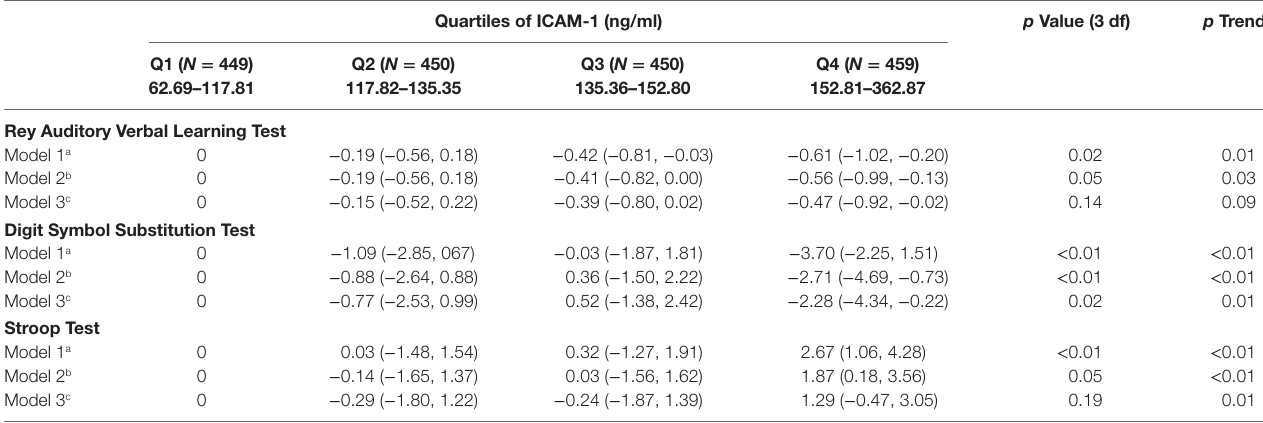
Table 3 | regression coefficients (95% ci) of year 25 cognitive test per year 7 intercellular adhesion molecule-1 (icaM-1) ( N = 1,798 for icaM-1). Quartiles of icaM-1